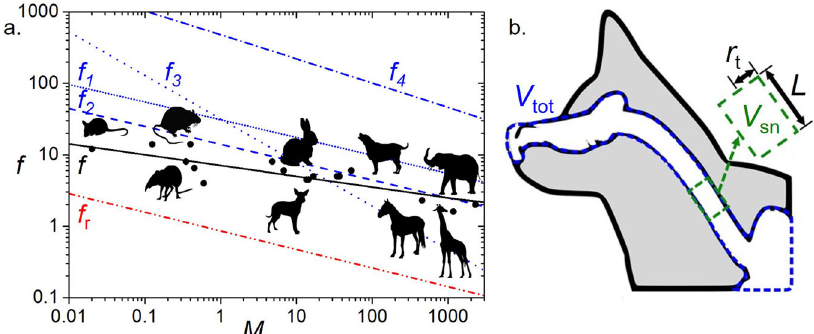
Fig. 2 Biological snif fi ng. a The relationship between maximum observed sniff frequency f (Hz) and body mass M (kg). In addition to elephant snif fi ng trials conducted here, black data points are from dogs, rodents, rabbits, and shrews from previous studies as well as a rat, dog, horse, and giraffe from YouTube. The black solid line is the power law best fi t to the experiments. For comparison we include four theoretical predictions f i using blue lines and the respiratory rate shown by the red dot-dot-dash line. Animal silhouettes are from freepik.com. b Pro fi le of a dog ’ s nose, with the white cavities denoting the nose, nasal cavity, trachea, and lungs, moving from left to right. Here, V tot (in short dash blue) is the total volume of air which must be accelerated each sniff, V sn (in long dash green) is the snif fi ng tidal volume of new air brought into the respiratory system, r t is the trachea hydraulic radius, and L is the change in position of the snif fi ng front.